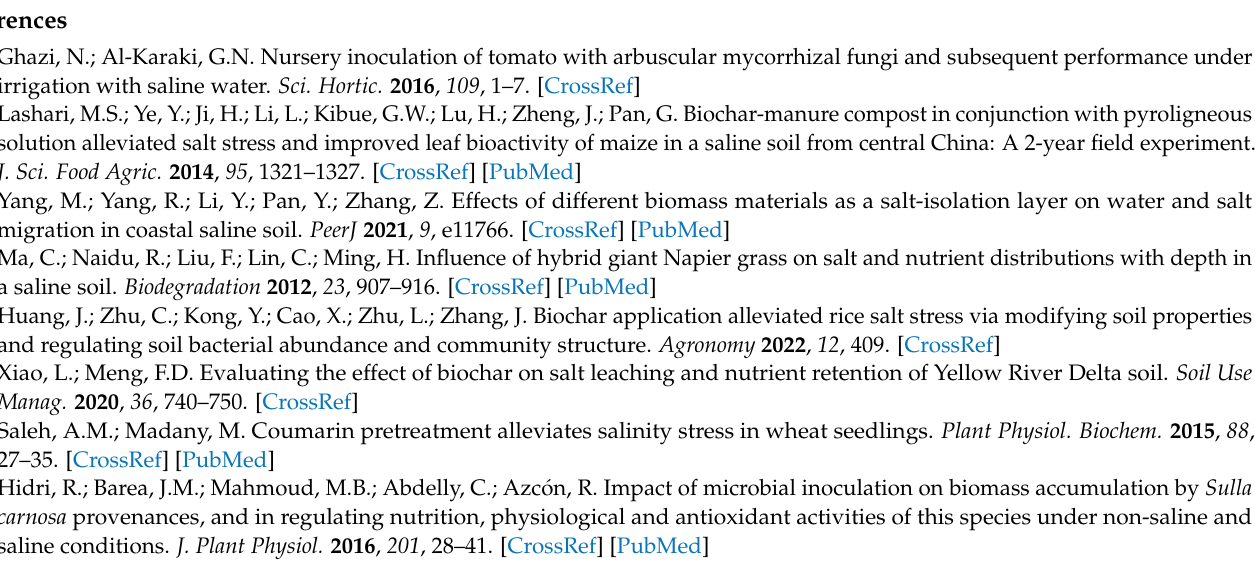
Table S2: Operational taxonomic unit richness and diversity indices of different samples; Table S3: top 38 genera attribution; Table S4: Correlation network analysis of microbial communities; Table S5: Node and degree in correlation network